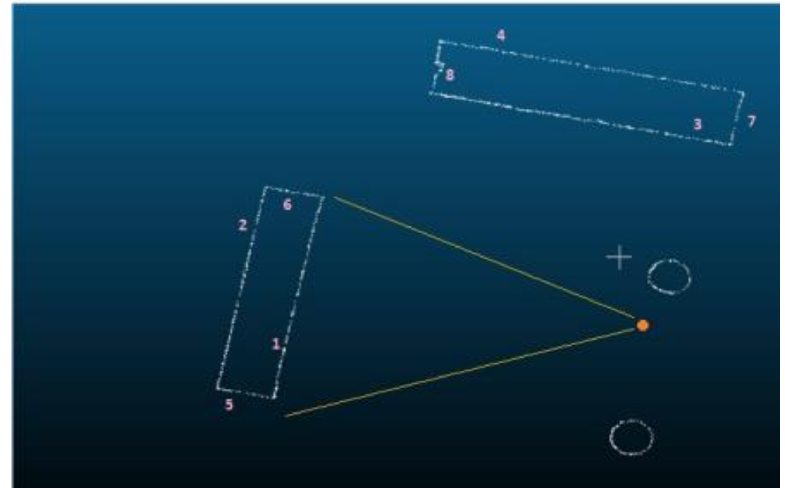
Figure 6. Candidate edges (#1–8) after the first part of the